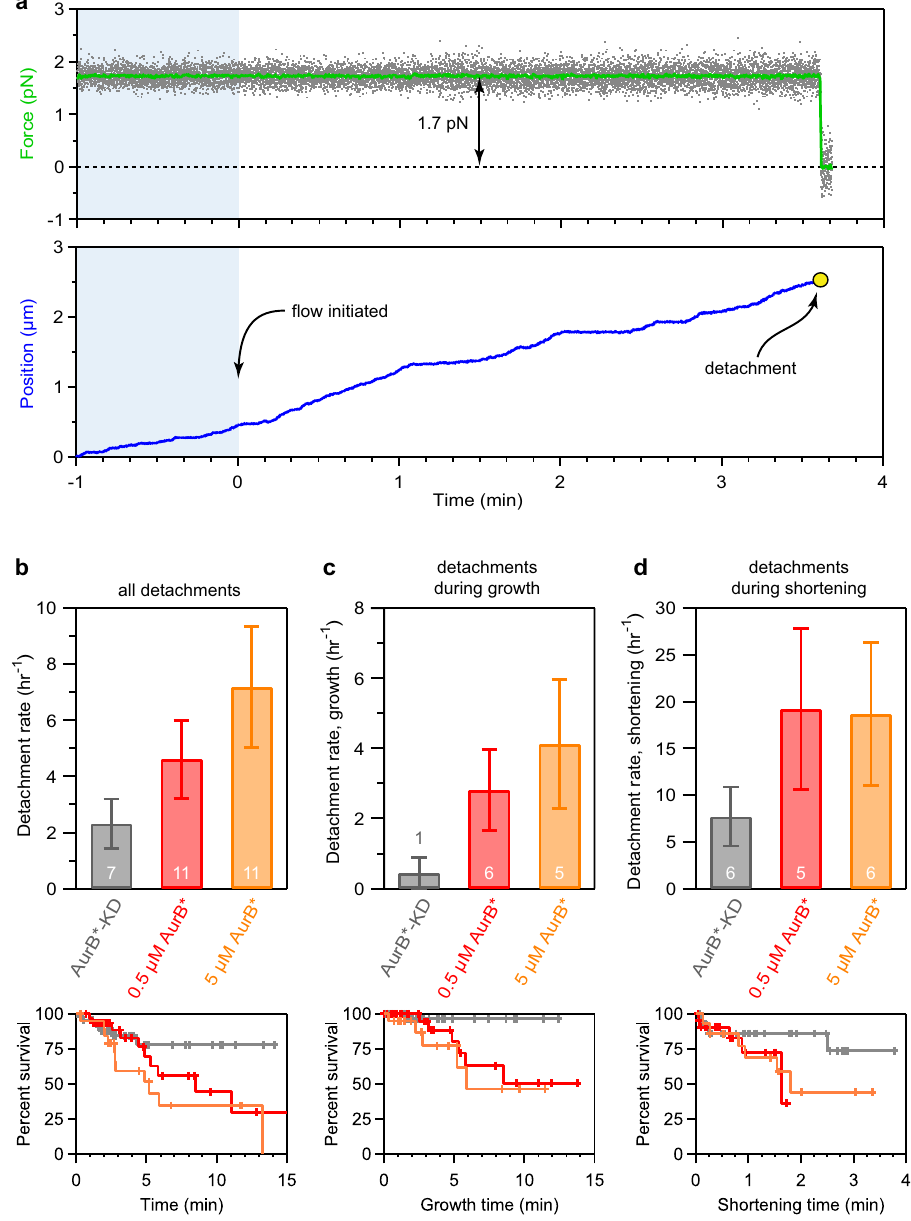
Fig. 3 Aurora B activity is suf fi cient to release kinetochores supporting low tension from the tips of dynamic microtubules. a Example record of optical trap data for an individual detachment event. Gray points show the force applied and green trace shows the same data after smoothing. Blue trace shows the relative position of the kinetochore-decorated bead over time. Kinase introduction occurred at time 0; blue shading indicates data recorded